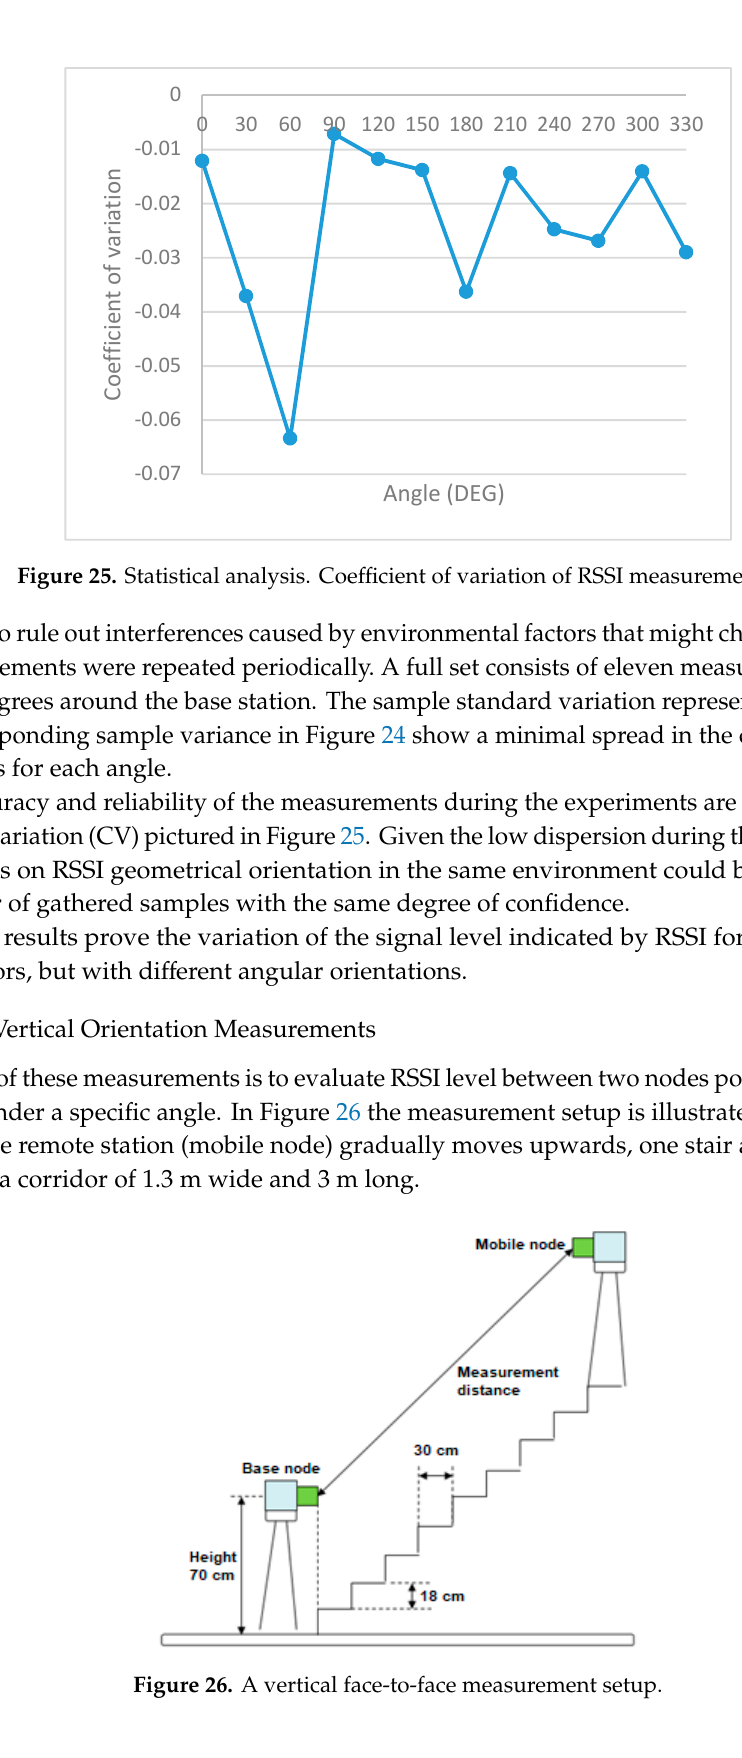
16 of 20 Figure 23. Statistical analysis. Sample standard deviation of RSSI measurements. Figure 24. Statistical analysis. Sample variance of RSSI measurements.